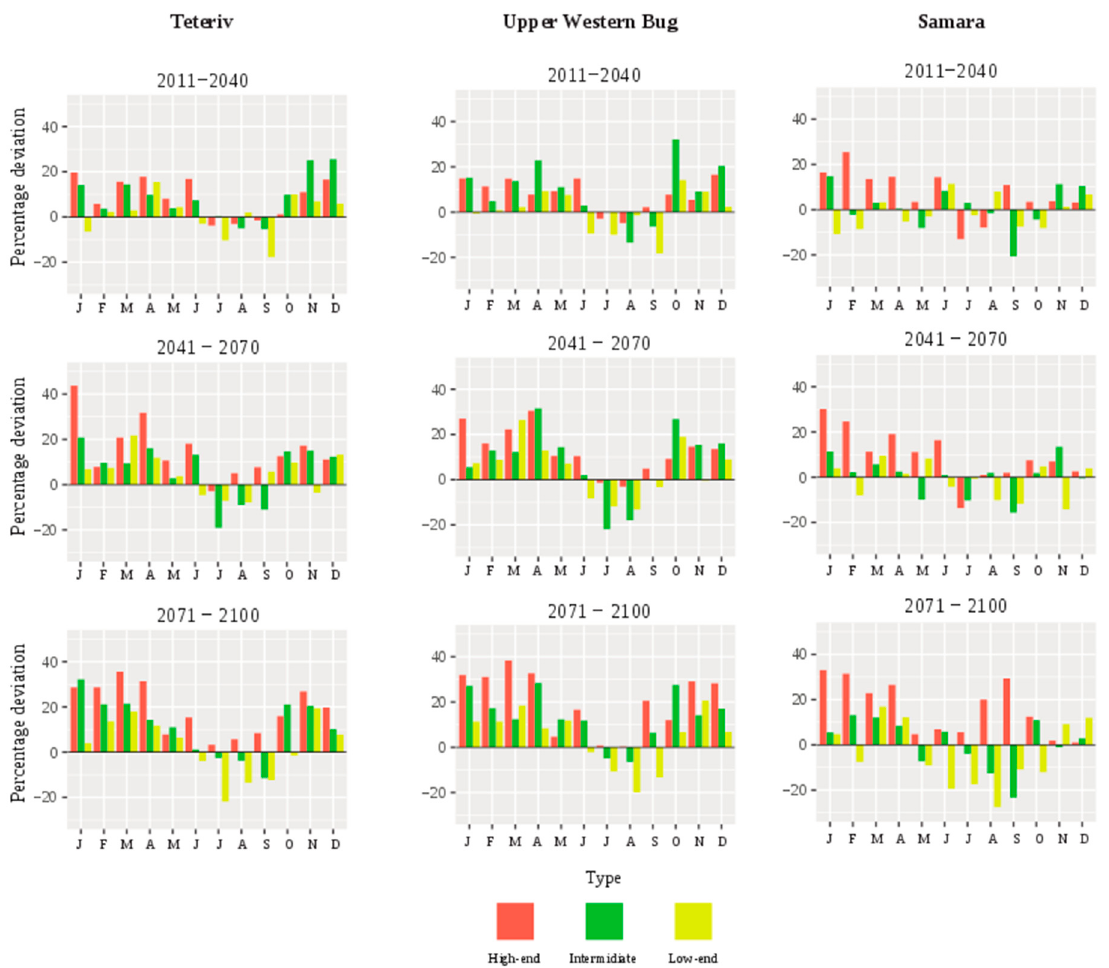
Figure 3. Climate change signals for precipitation in the catchments under study for three future periods compared to the reference period under three scenarios.